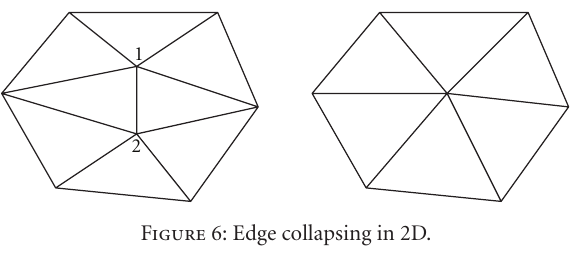
Figure 8: Springs’ movement based on node neighbours: springs contracting.